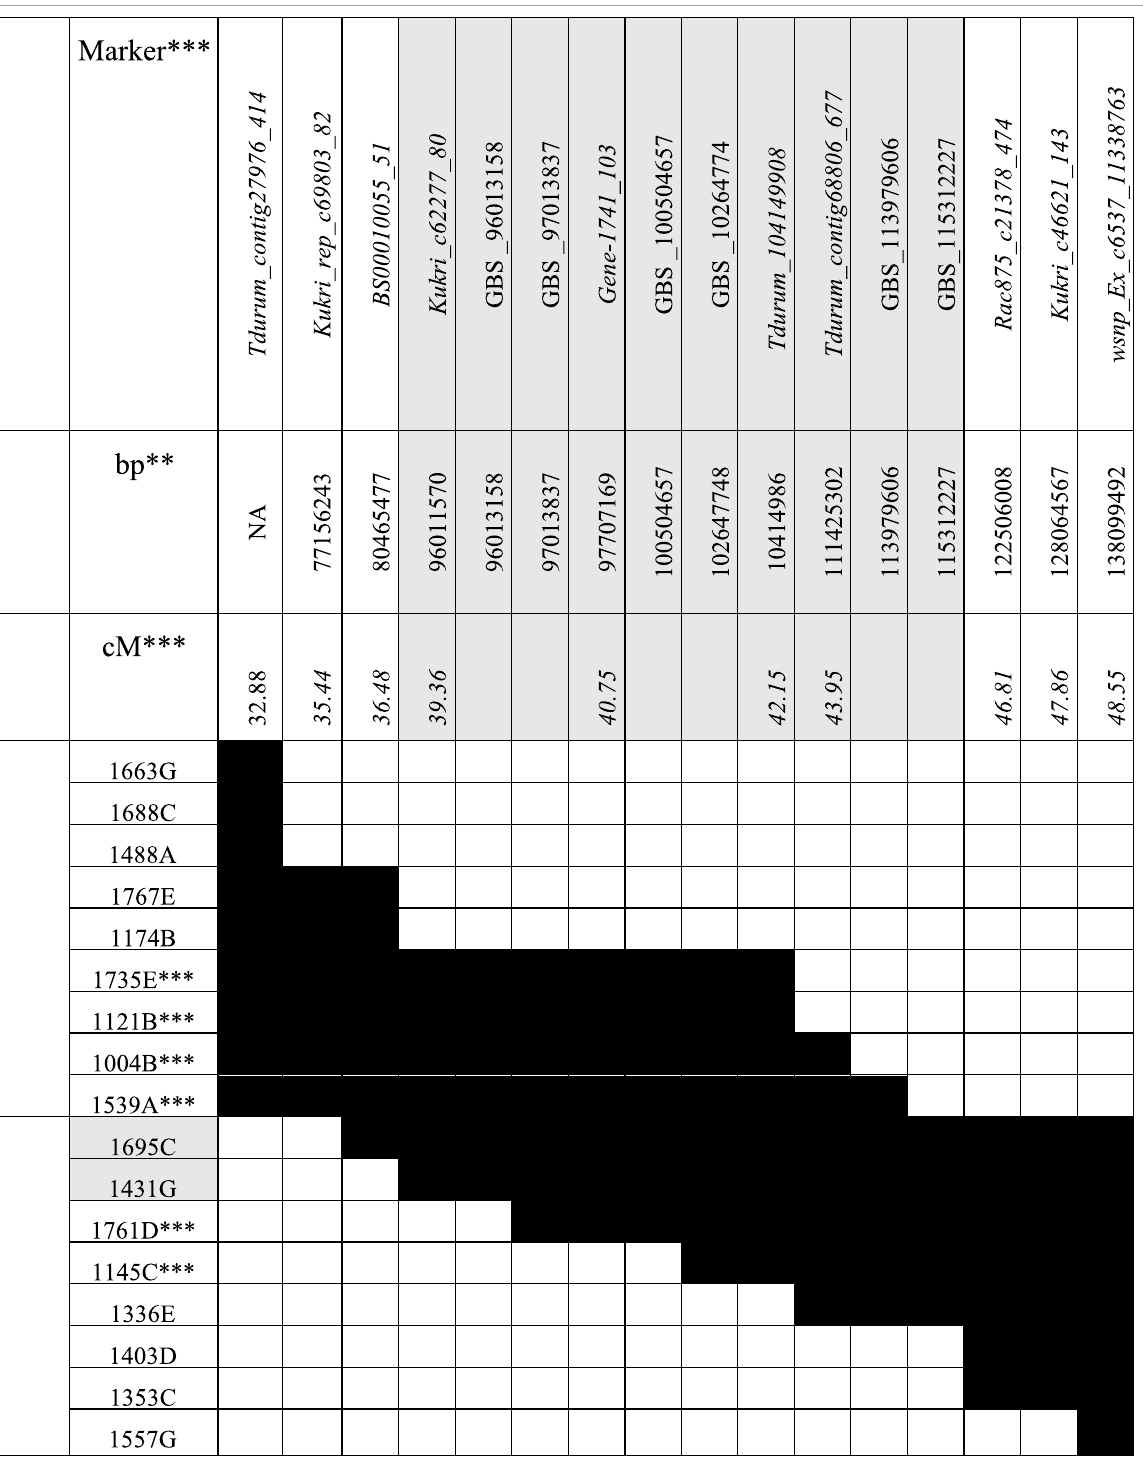
TABLE 2 Genotypic data of the recombinant inbred